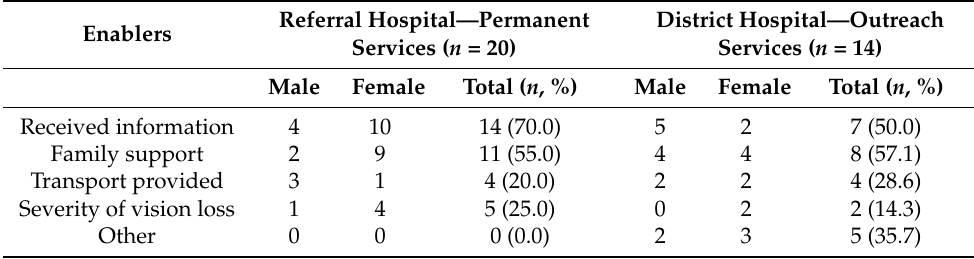
Table 4. Enabling factors for people with severe vision impairment or blindness attending their cataract surgical appointment in Rwanda, May–July 2019 ( n =